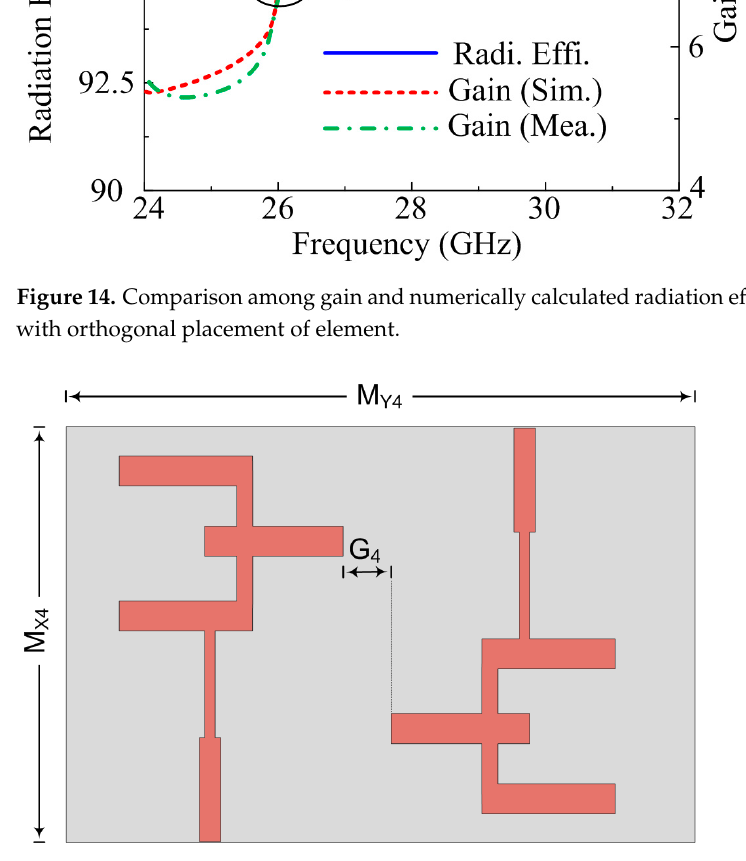
Figure 15. Schematic of MIMO antenna for opposite elements.